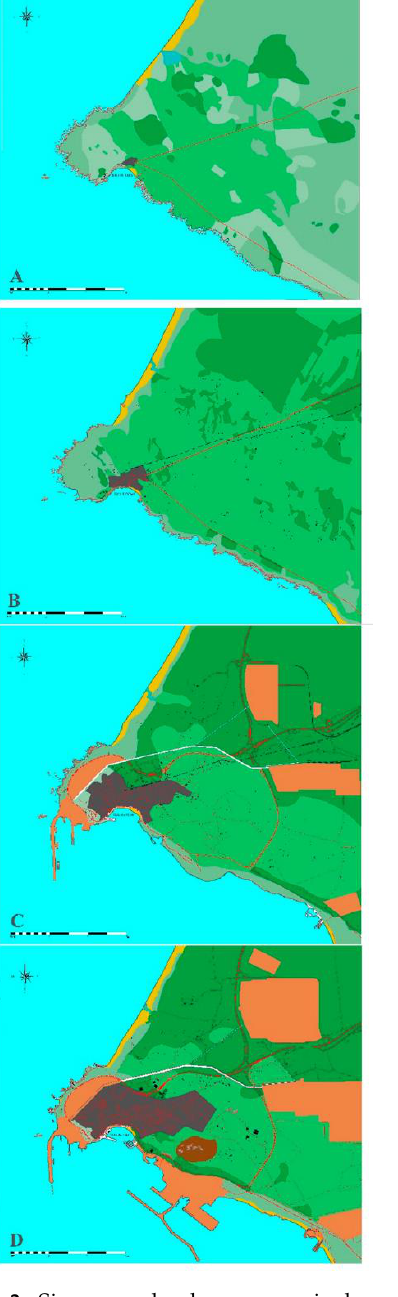
Figure 3. Sines cape landscape mosaic dynamic from former to current times: ( A )—Former times (main source of information: 1890–1900 agricultural and forest historical map— Carta de Pery ); ( B )—Mid 20th century (main source of information: 1947 military maps and 1960 Agricultural and forest maps); ( C )—End of 20th century (main source of information: 1987 military maps and 1990 CORINE land cover); ( D )—Present time (main source of information: current digital maps, 2018 COS and Google Earth).